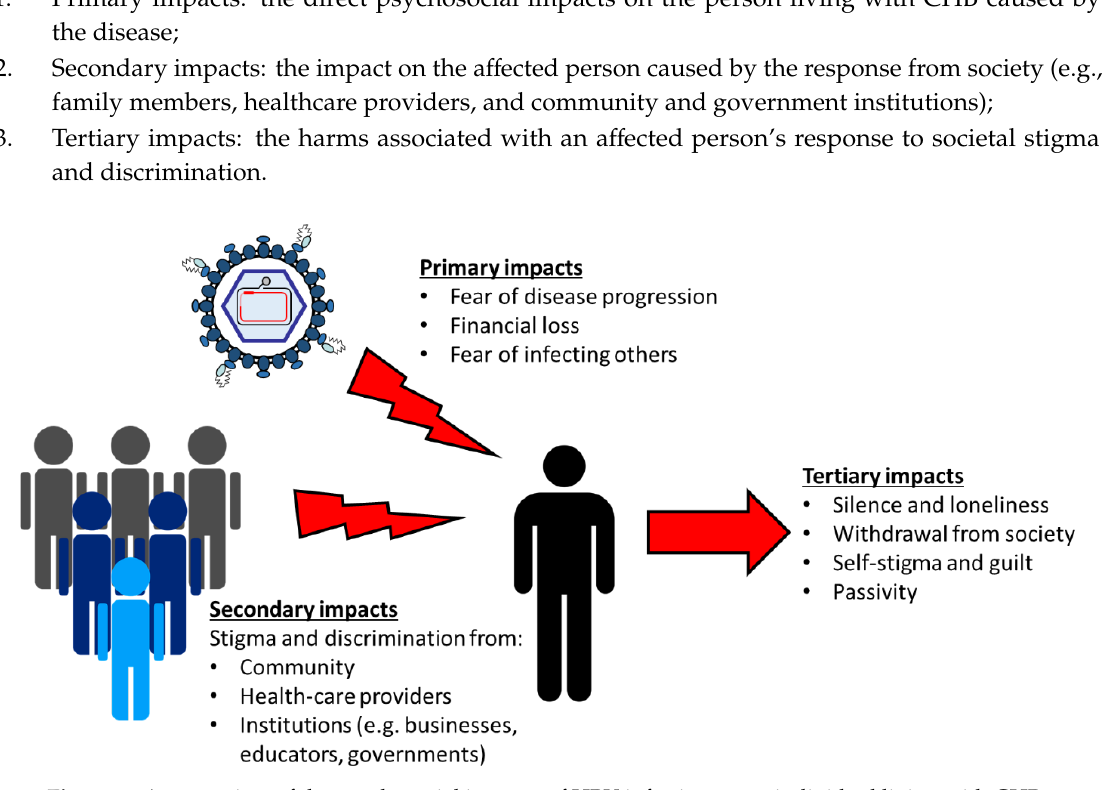
TT: Almost 300 million people worldwide have chronic hepatitis B infections and 884,000 people die from its complications every